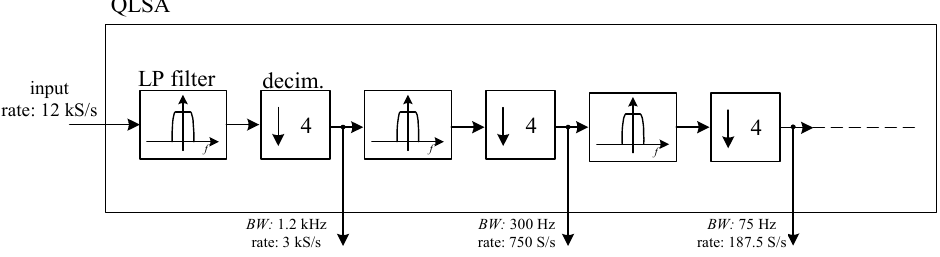
Figure 8. Filtering and decimation as performed by QLSA (Quasi-Logarithmic Spectrum Ana-